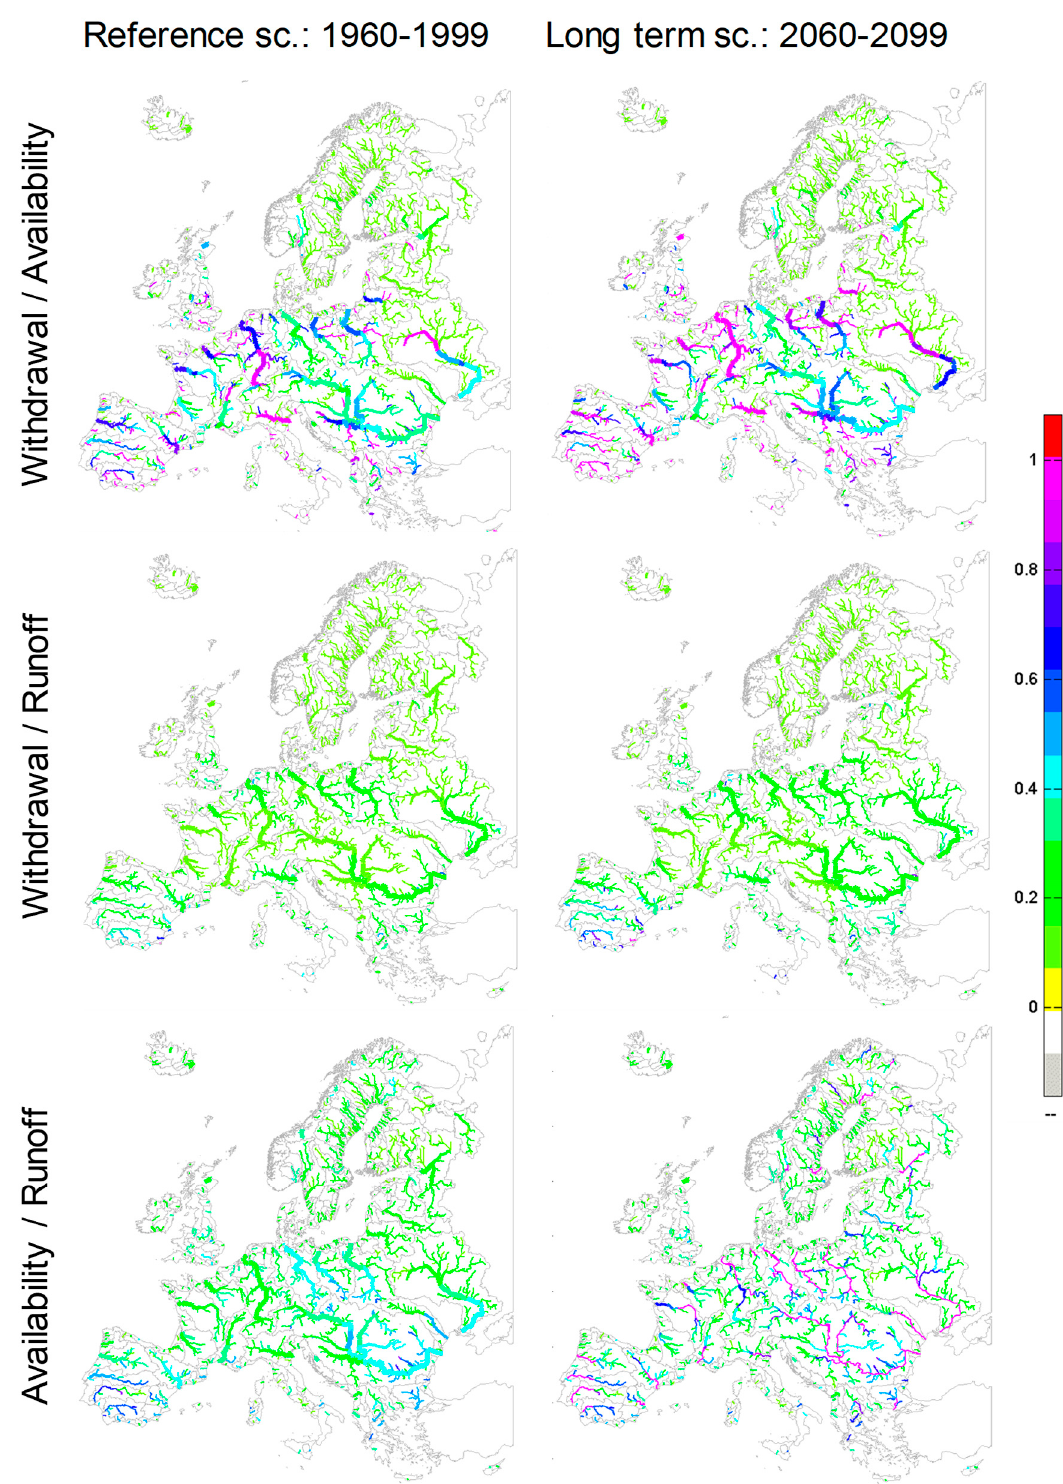
Figure 8. Spatial distribution of the per unit change of potential water availability between the historical period (1960–1999) and the long-term period (2070–2099) for the model GFDL, under the emissions scenario RCP4.5. ( Top row ) Withdrawal as a fraction of availability. ( Centre row ) Water withdrawal as a fraction of runoff. ( Bottom row ) Potential water availability as a fraction of runoff.